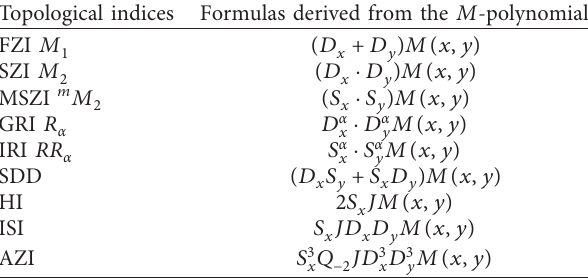
Table 1: Formulas to derive some promising invariants from the M -polynomial.